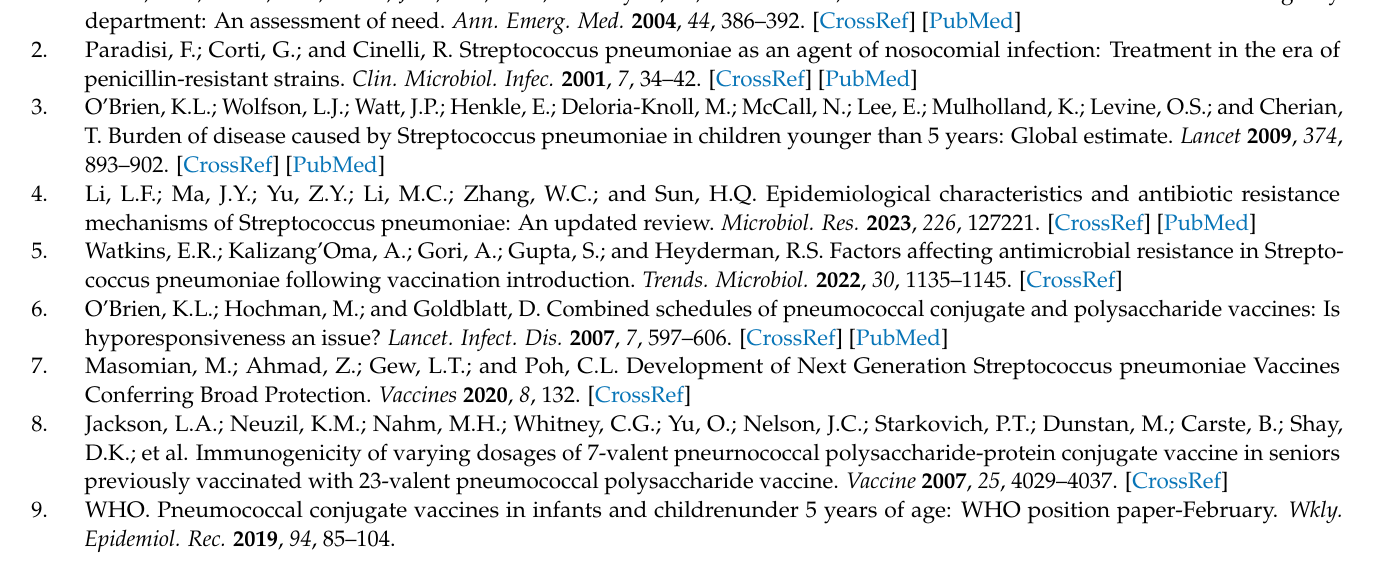
lncRNAs used in qPCR. Table S2: Quality control of the sequencing data. Table S3: The information for the identified lncRNAs. Table S4: Differentially expressed genes. Table S5: Differentially expressed lncRNAs. Table S6: GO terms analysis of differentially expressed mRNAs. Table S7: KEGG pathways analysis of differentially expressed mRNAs. Table S8: lncRNAs–mRNAs significantly correlated pairs. Table S9: GO terms analysis of differentially expressed lncRNAs. Table S10: KEGG pathways analysis of differentially expressed